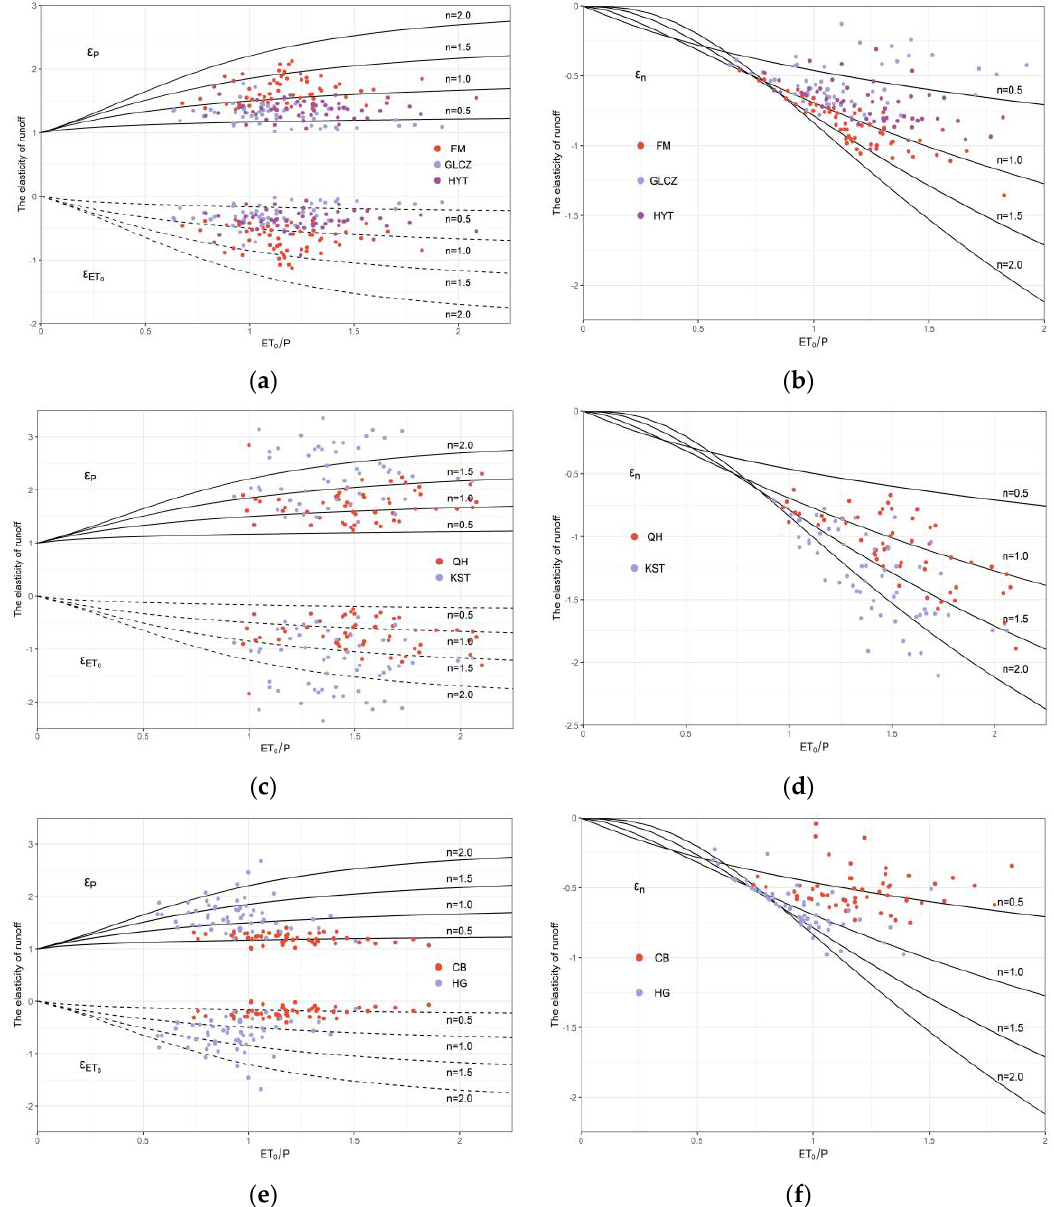
Figure 5. Relationship between the elasticity of runoff and the dryness index under different parameter values of 𝑛 . ( a , b ) Second Songhua River Basin, ( c , d ) Tumen River Basin, ( e , f ) Yalu River Basin. Fengman (FM), Quanhe (QH), Huanggou (HG), Gaolichengzi (GLCZ), Hanyangtun (HYT), Kaishantun (KST), and Changbai (CB) hydrological stations.